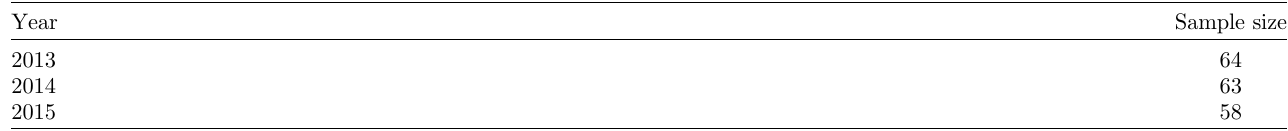
Table 4. Number of observations by